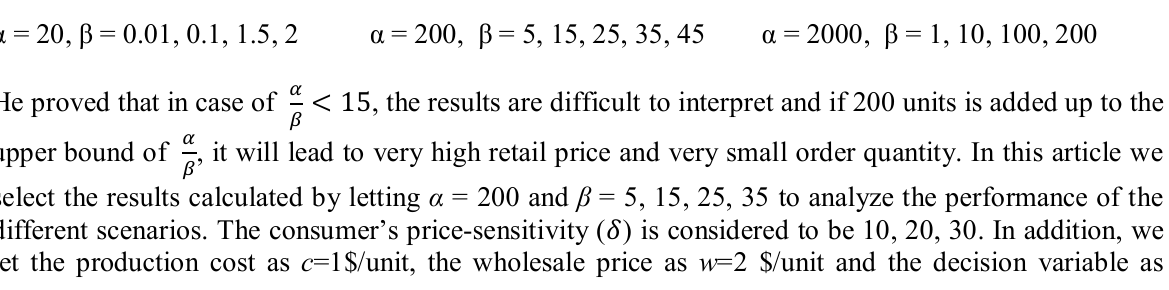
Scenario 2 (Coordination with Revenue